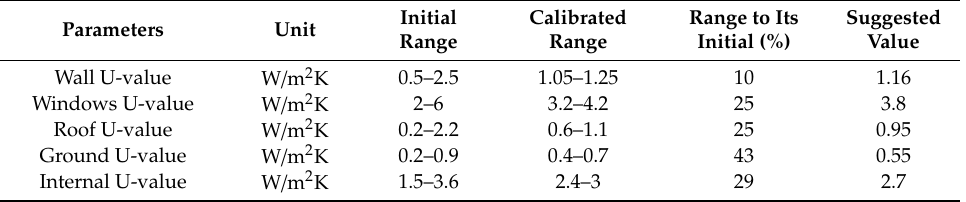
Table 3. Calibrated parameters with initial range and calibrated